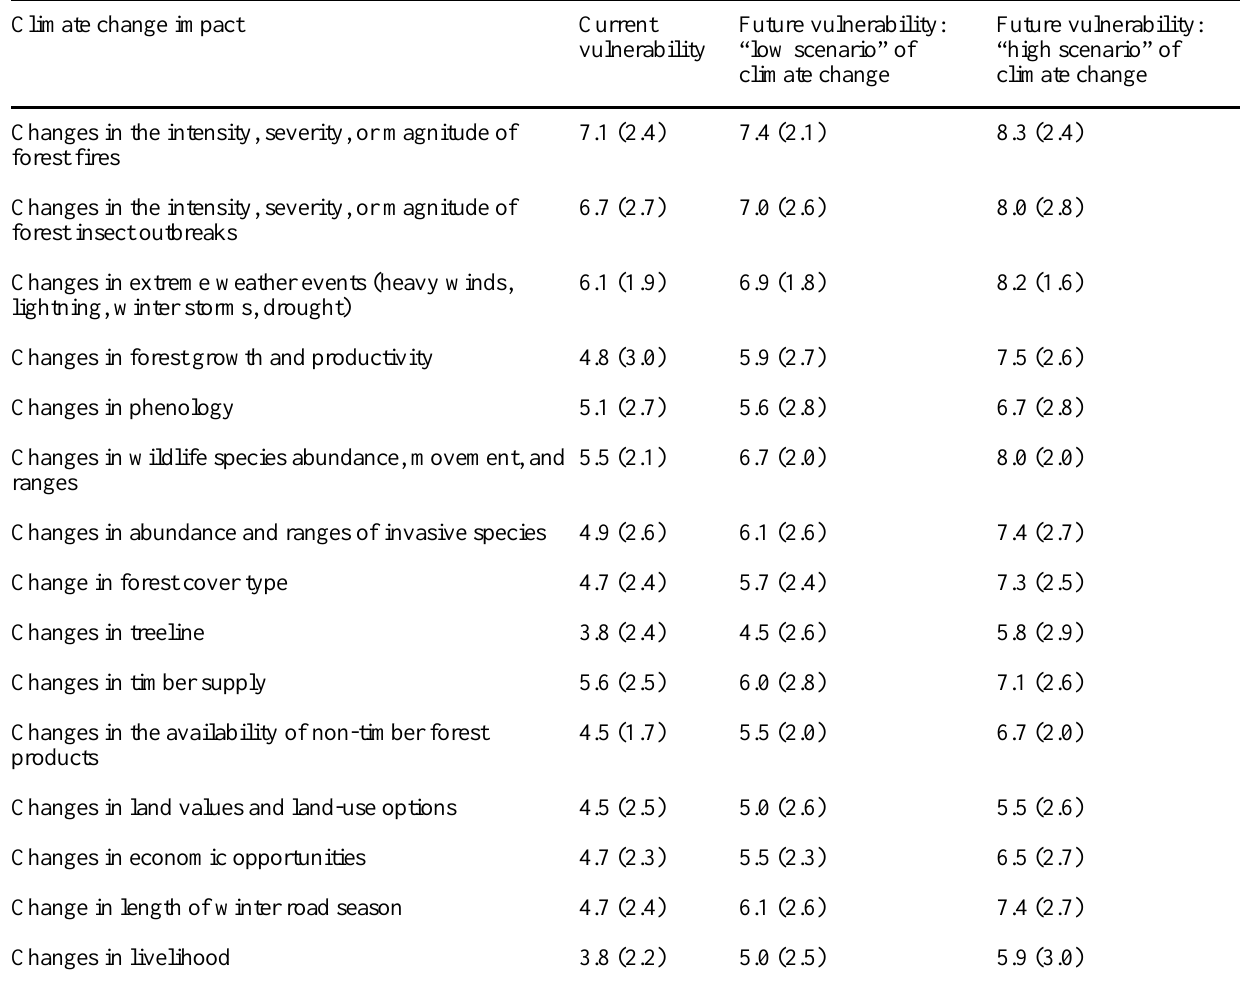
Table 3. Judgments of forest practitioners on the degree to which the forest sector and forest-dependent communities in the Champagne and Aihihik Traditional Territory are vulnerable to the following impacts of climate change. Vulnerability is the extent to which climate change may damage or harm a system. It depends on a system’s sensitivity and ability to adapt to new climate conditions. Scale of 1 to 10 (0 = not vulnerable, 1 = low vulnerability, 10 = high vulnerability) or don’t know. Results shown are the average rank and standard deviation (s.d.; in parentheses) of participants who provided a